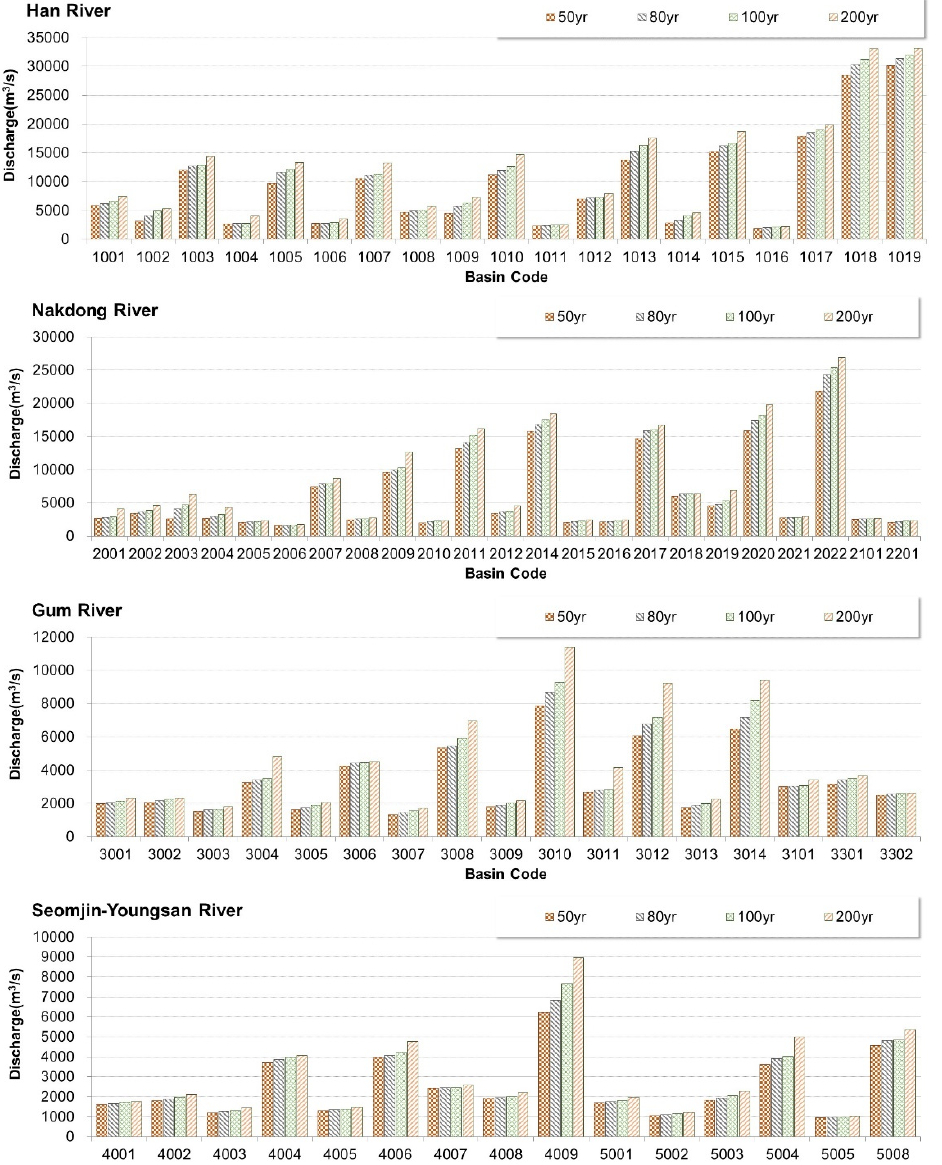
Figure 3. n-year floods according to the RCP 4.5 (CMCC-CM, Total Period).